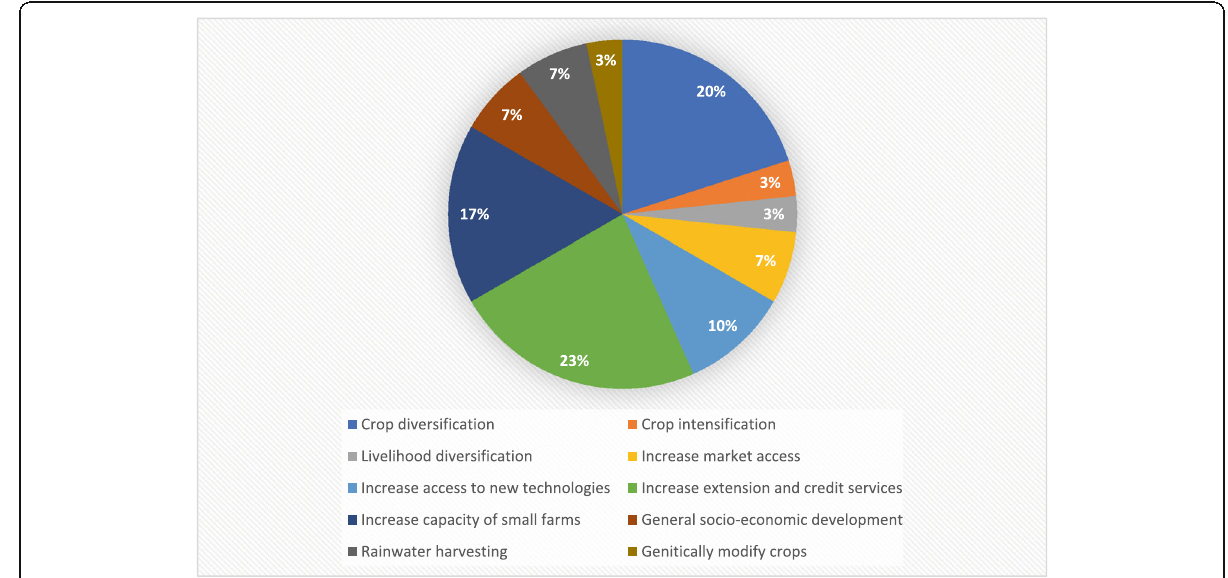
Fig. 4 Recommendations for future adaptation